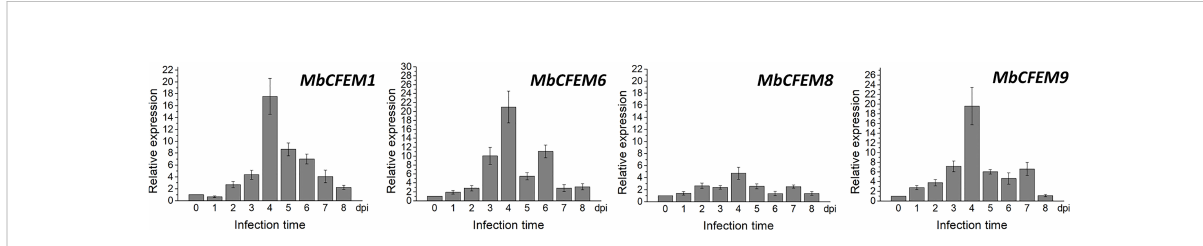
FIGURE 3 Transcript pro fi les of four candidate MbCFEMs in M. brunnea -infected poplar leaves at 0, 1, 2, 3, 4, 5, 6, 7, and 8 days post inoculation (dpi). Relative expression levels of four candidate MbCFEMs (MbCFEM1, MbCFEM6, MbCFEM8, and MbCFEM9) were determined by quantitative reverse-transcriptase polymerase chain reaction (qRT-PCR) using the M. brunnea housekeeping gene EF-1 a ( elongation factor 1- a ) as an internal standard. Values are means ± standard deviations (as error bars) ( n = 3). This experiment was repeated three times with similar